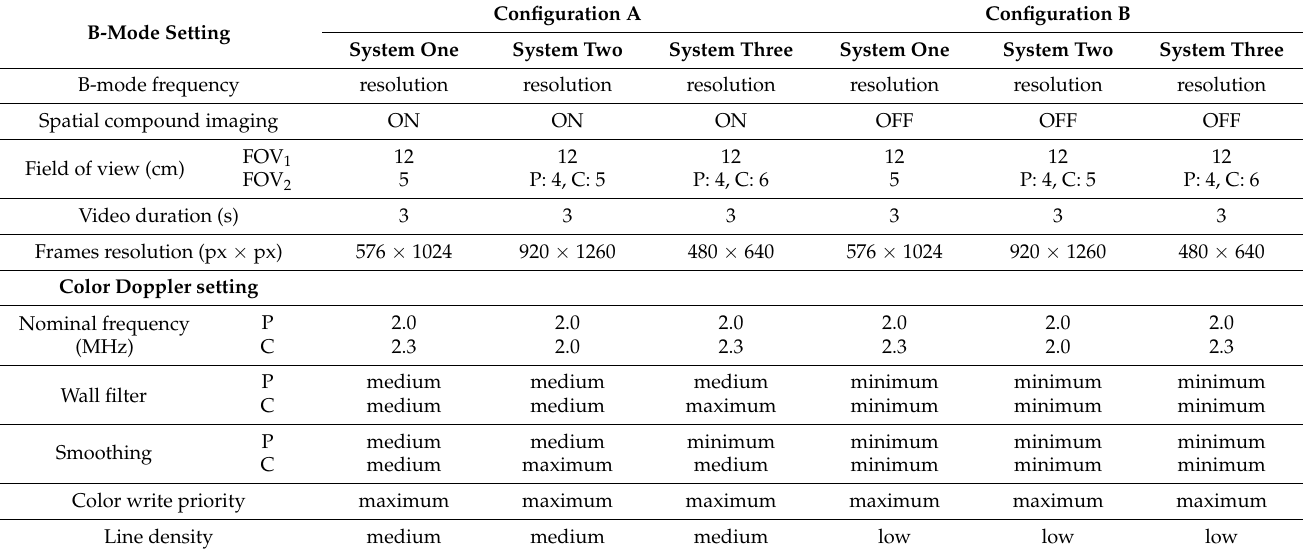
Table 2. Main B-mode and Color Doppler configuration settings according to the US system.